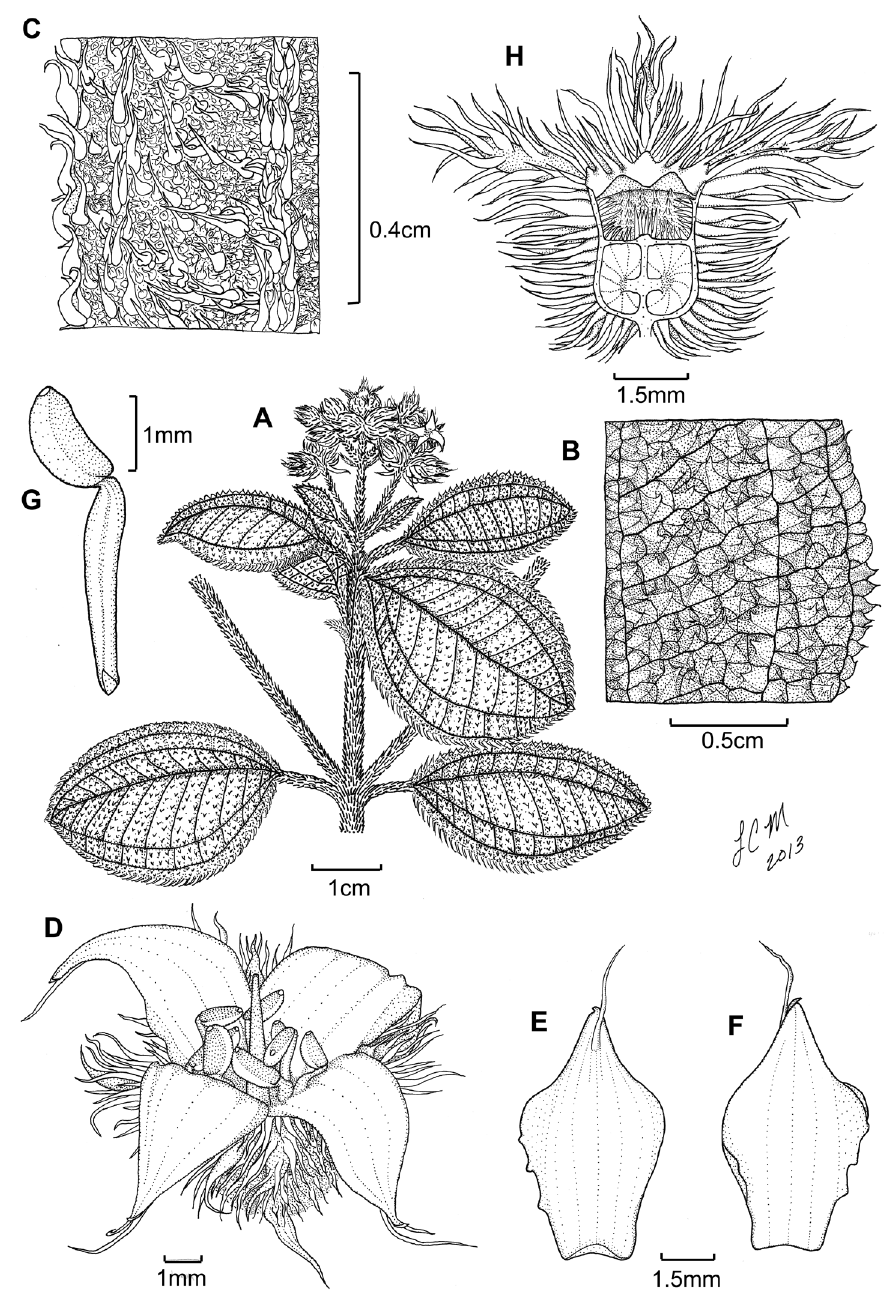
Figure 26. Illustration of Miconia paralimoides . A habit ( Veloz 4059 ) B close-up of upper leaf surface ( García 1186 ) C close-up of lower leaf surface ( García 1186 ) D flower Veloz 4059 ) E petal abaxial surface ( Veloz 4059 ) F petal adaxial surface ( Veloz 4059 ) G stamen ( Veloz 4059 ) H fruit longitudinal section ( F. Jiménez 176–A ). Reproduced with permission from Majure and Judd